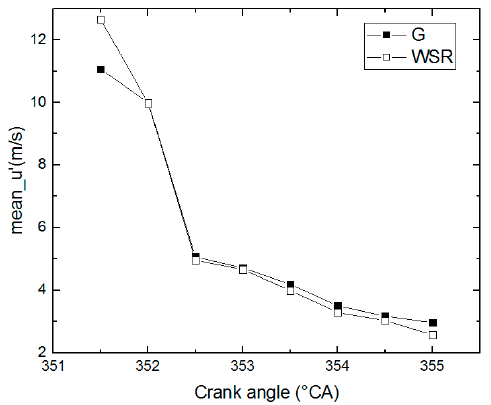
Figure 14. The mean turbulence intensity of jet flame at different times, using the WSR model and the G-equation model. Table 8. IMEP and NO x emission prediction results of cases 3, 5, 6 and 7 and the experimental data.